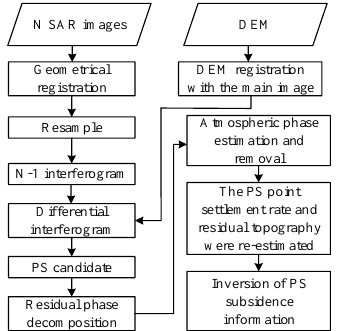
Figure 2. Data Processing Flow of